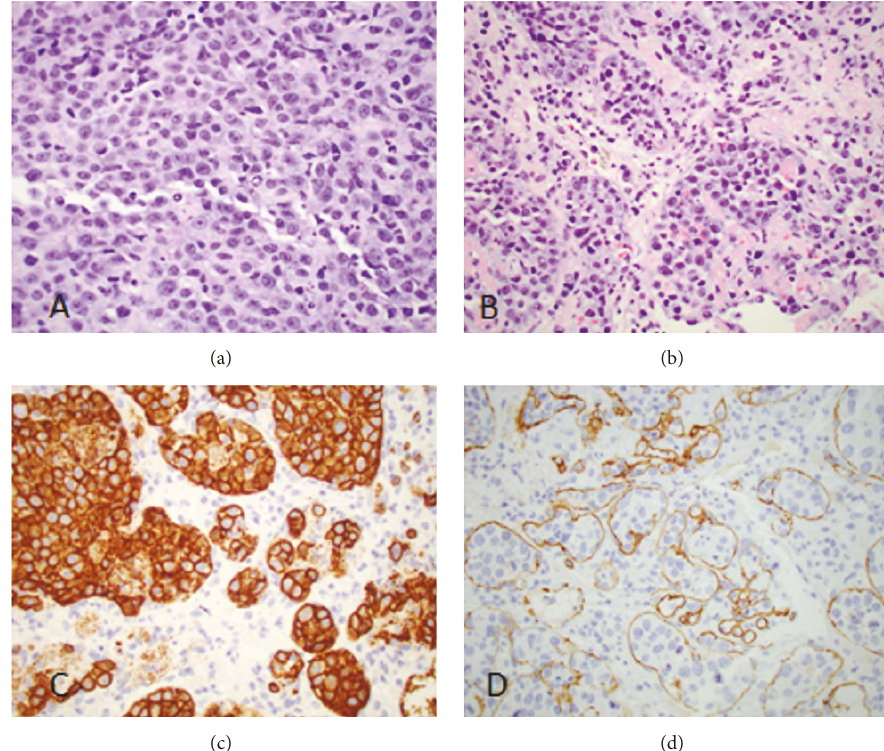
Figure 6: Histology images. The neoplastic lymphoid cells showed large vesicular nuclei ((a) H&E, original magnification × 600) and prominent intravascular growth pattern ((b) original magnification × 400). They were positive for CD20 ((c) original magnification × 600). CD34 stain ((d) original magnification × 400) highlighted vascular channels containing neoplastic lymphoid cells, confirming the intravascular growth